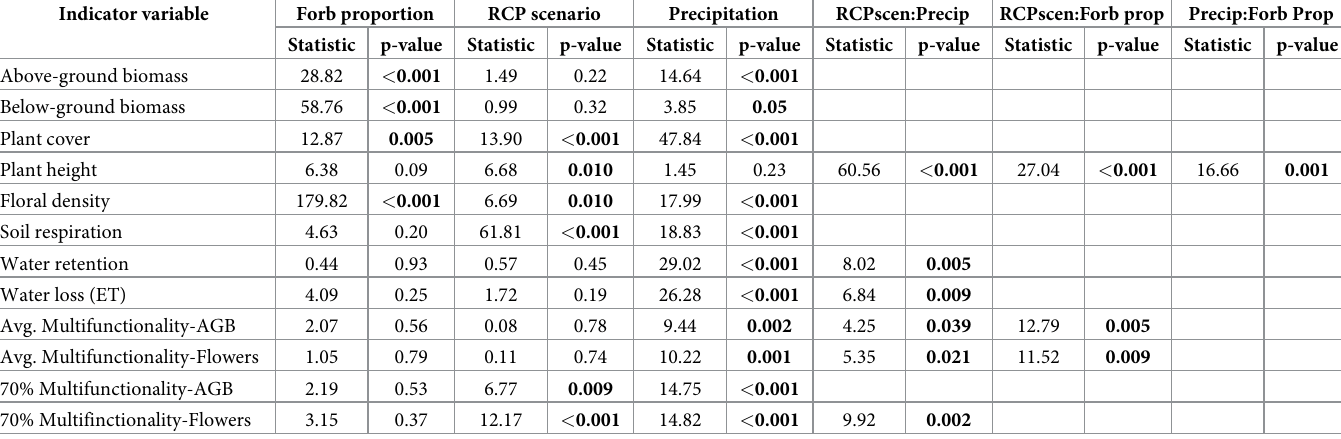
Responses were analyzed with generalized linear mixed-effects models (GLMMs). Climate chambers were considered as random factors. Shown are outputs of ANOVA tables displaying the significance of the tested drivers after model simplification. Degrees of freedom are forb proportion (df = 3), precipitation (df = 1), RCP scenario (df = 1), RCP scenario x precipitation, forb proportion x RCP scenario (df = 3), and forb proportion x precipitation (df = 3). Significance level set at p � 0.05 and depicted in bold (n =